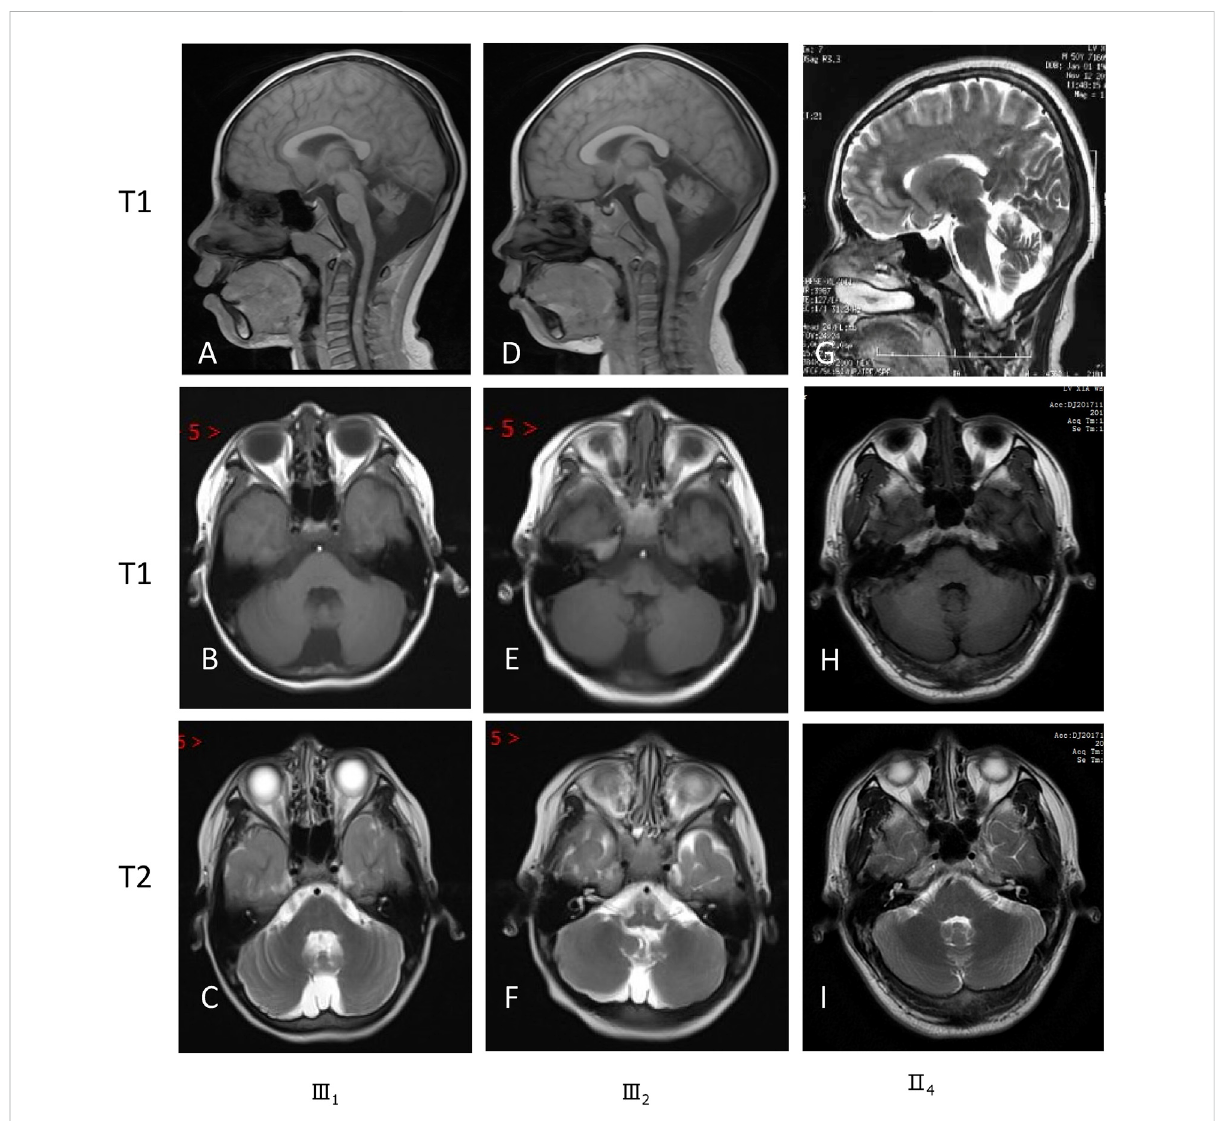
FIGURE 3 Magnetic resonance images show severe hypoplasia of the cerebellum (III1 and